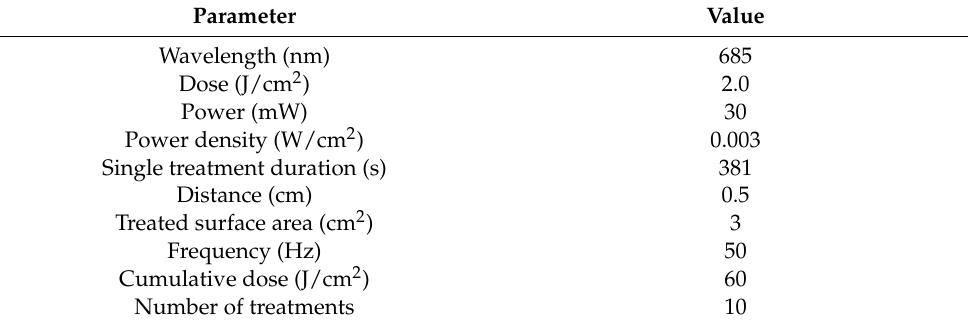
Table 2. Relevant technical data for low-level laser therapy (BTL2000 Medical Technologies,